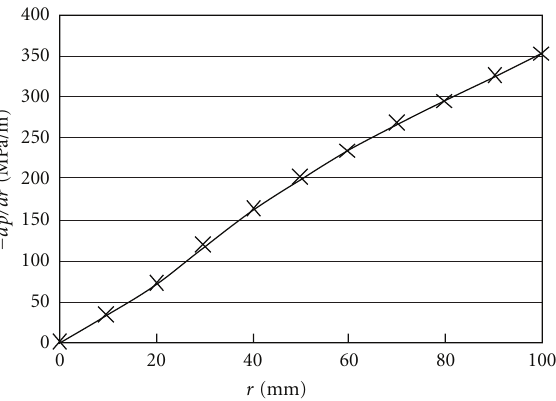
Figure 5: The pressure gradient versus radius.